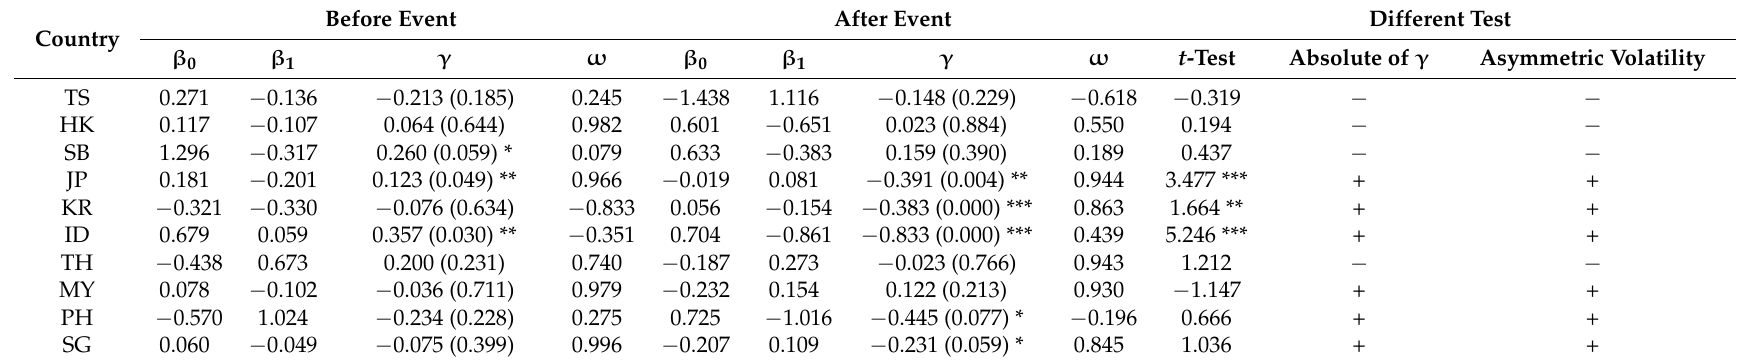
Table 17. The EGARCH model result: European debt